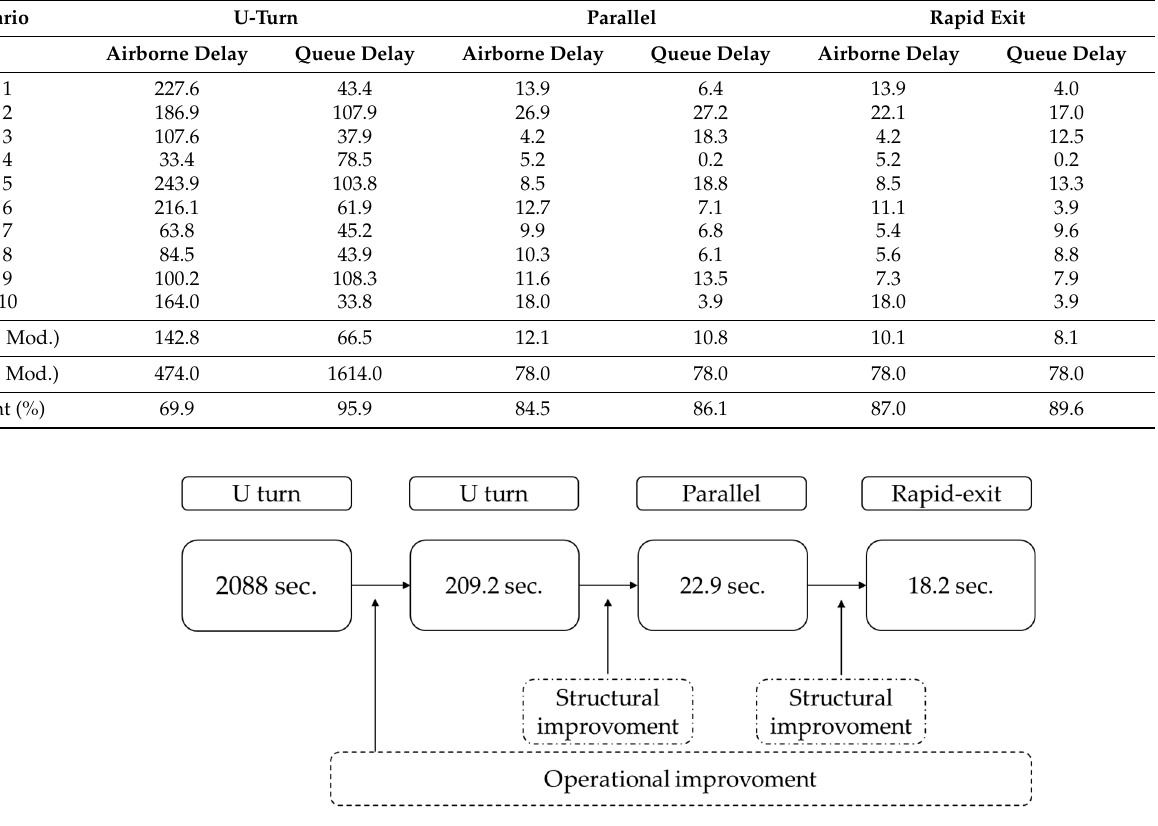
Figure 5. Optimal road map for sample scenario.